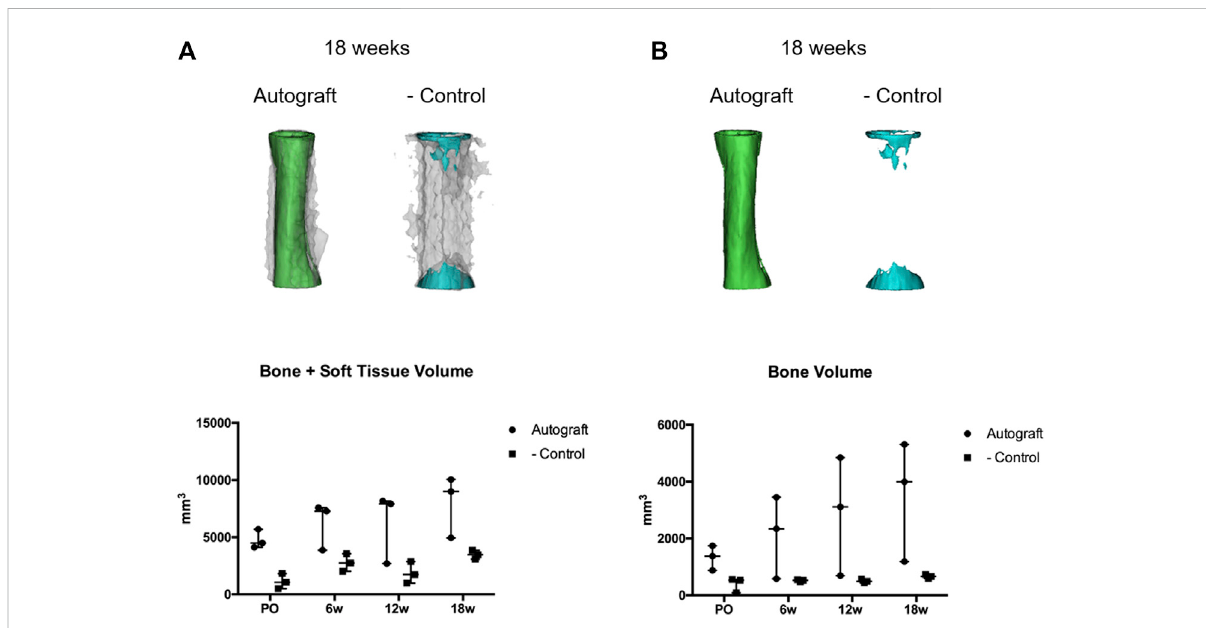
FIGURE 4 Quantitative assessment of bone and soft tissue using computed tomography (CT) and Mimics segmentation software. CT data from autograft and negative control dogs were exported to a commercially available segmentation software (Mimics 19.0, Materialise Inc., Leuven, Belgium). Segmentationofboneandsofttissueswereperformedtogenerate3Dmodelsandquantifytissuewithinthecriticaldefects. (A) Representativebone within autograft (green) or negative control (blue) treatment groups at 18 weeks. Soft tissue is represented by the translucent gray overlay. (B) Representative bone within autograft (green)and negative control (blue)treatmentgroups at18 weeks.Volumetricdata (mm 3 )for bone+ softtissue (A) or bone (B) were reported using scatter plots denoting median and range.